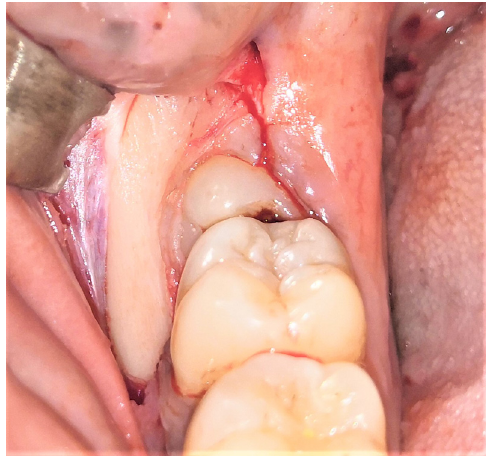
Fig. 2. Surgical exposure of buccal based triangular fl ap technique.